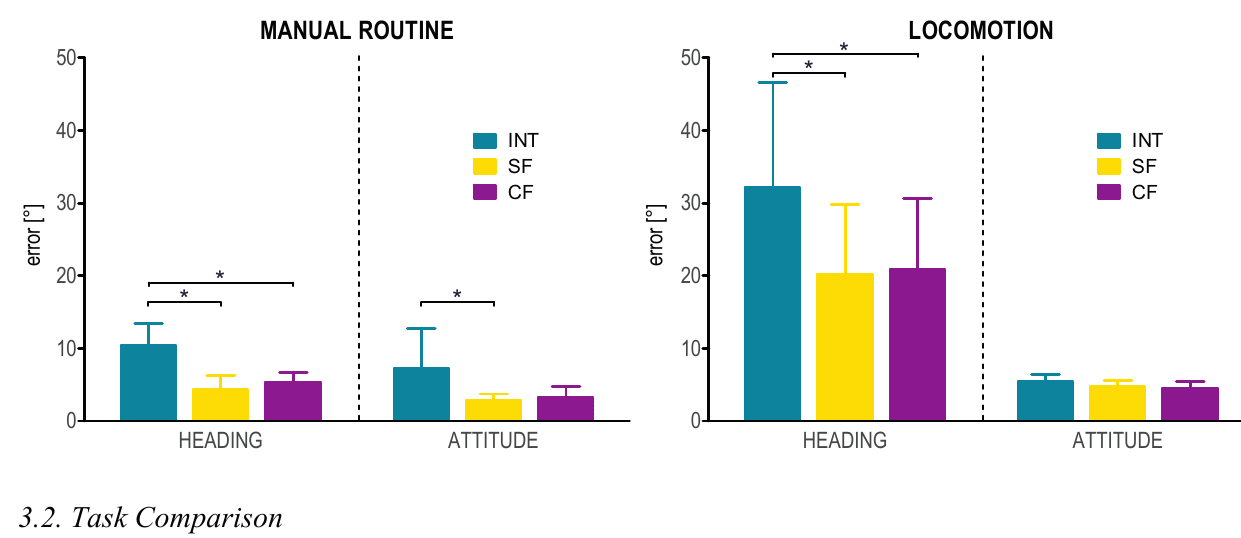
Figure 4. Heading and attitude errors (mean and one standard deviation) for the manual routine (on the left) and the locomotion (on the right) tasks. Significant differences among the INT, SF and CF methods are indicated with an